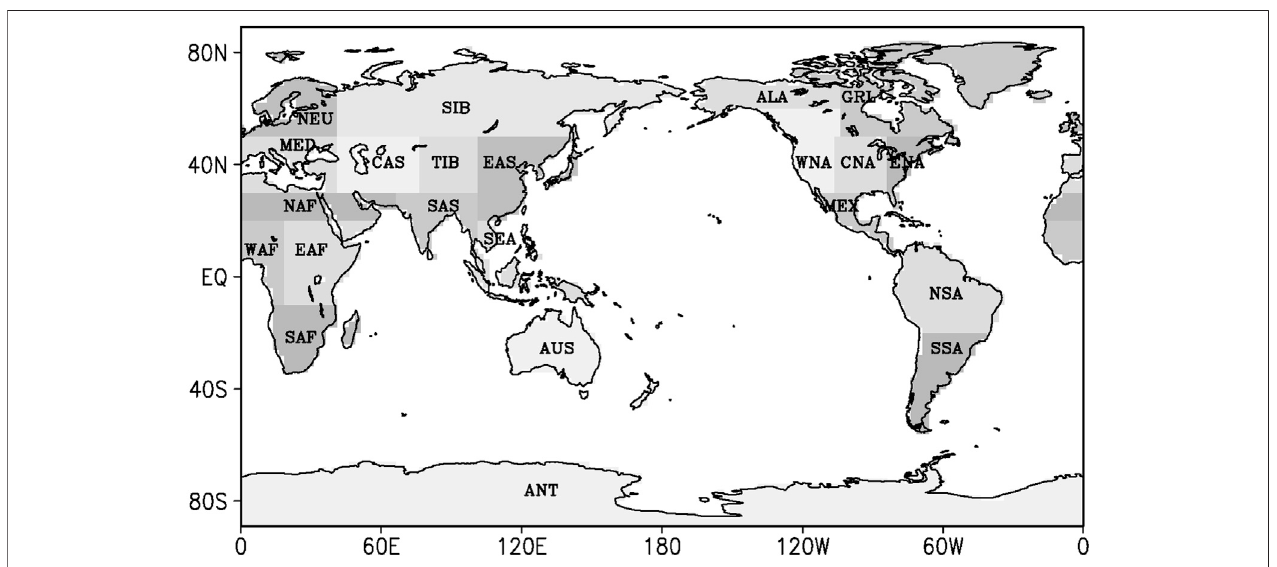
FIGURE 1 | Divisions of the continents on earth.